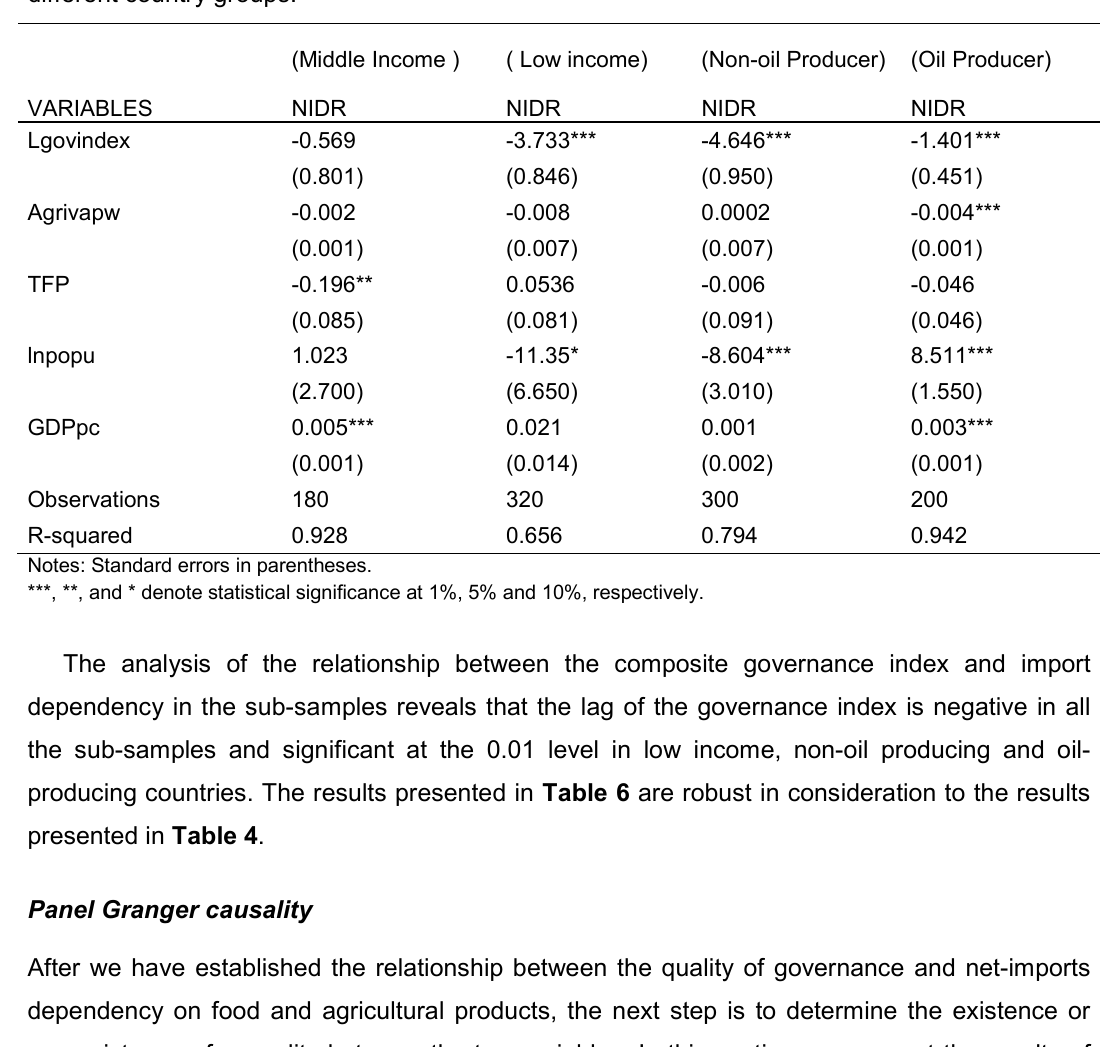
Table 6. Regression result for the composite governance index and net-import dependency in different country